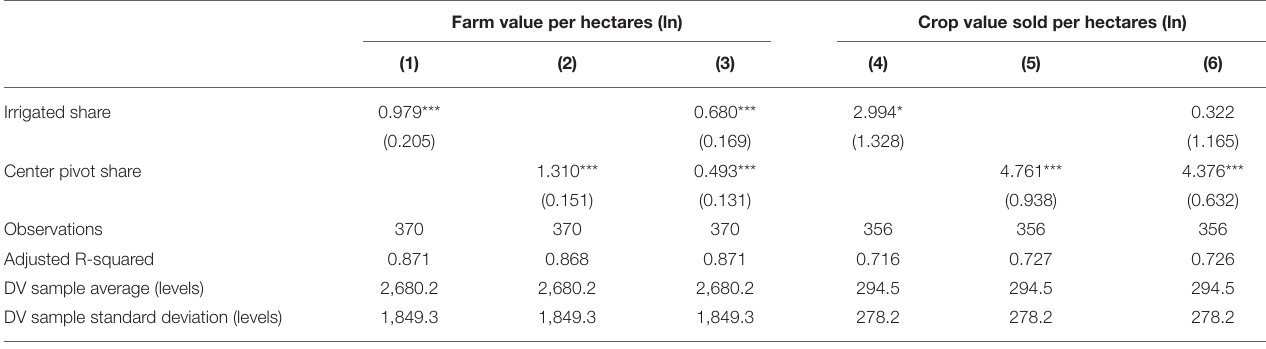
TABLE 2 | Irrigation, farm value and production,